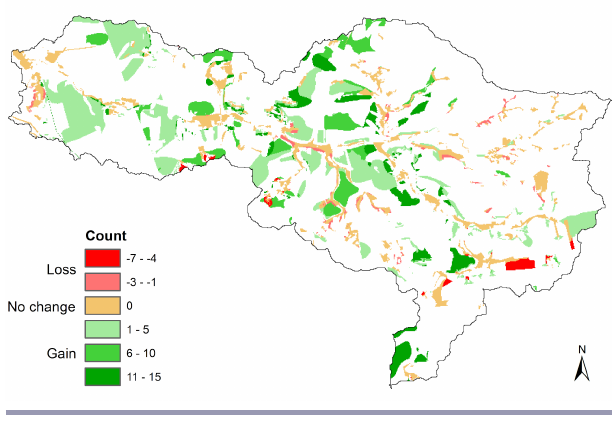
Fig. 8. Gain and loss of intensive grassland patches for the 15 best solutions for willingness to pay function 2 compared to the status quo. Red = loss of intensive grassland; orange = no change; green = gain in intensive grassland. Counts indicate the number of times out of 15 that the patch was affected.